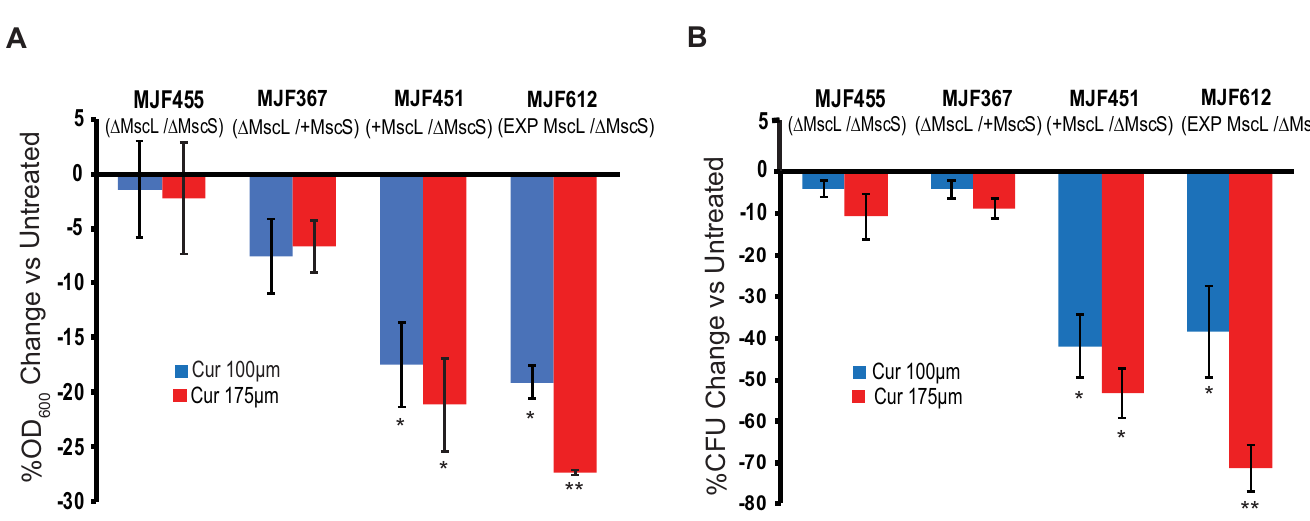
Fig 2. Endogenous expression levels of MscL are sufficient for curcumin antibiotic action. Shown are the E . coli Stains MJF455 ( Δ MscL, Δ MscS), MJF367 ( Δ MscL), MJF451 ( Δ MscS), MJF612 ( Δ MscL, Δ MscS, Δ MscK, Δ ybdG) carrying empty plasmid (MJF455, MJF367, MJF451) or expressing MscL (MJF612) treated with curcumin at 100 μ M (blue) or 175 μ M (red). A) Inhibition of growth (OD 600 ) in the presence of curcumin graphed as the percentage change of untreated. B) The reduction in viability of cultures shown in A as the percent change of colony forming units (CFUs) vs Untreated. Note that only when MscL is expressed either at endogenous- levels or by heterologous expression, the presence of curcumin has an effect on growth and viability. n = 3, Statistics reflect a comparison of MscL-expressing strains versus MJF455 � P < 0.05, �� P < .005 as indicated, 2-tailed, homoscedastic t-test.